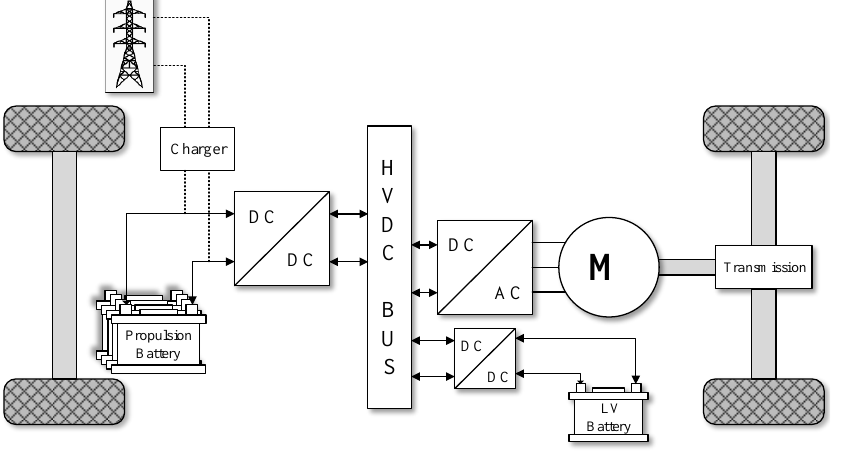
Figure 1. Powertrain of an electric vehicle.